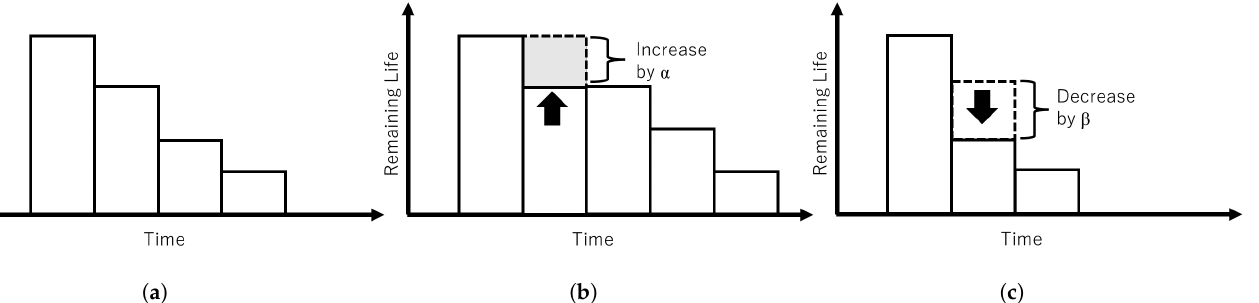
Figure 3. Mechanism of remaining life according to node status. ( a ) Normal white-hat botnets’ remaining life over time. ( b ) Remaining life when a white-hat botnet node detected an infected node. ( c ) Remaining life decreases when a white-hat botnet node congregates with another white-hat botnet